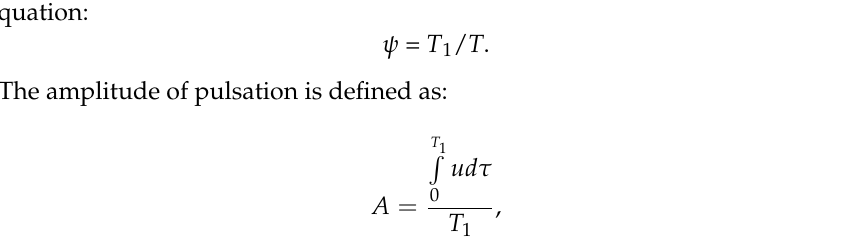
Figure 3. The pulsating velocity examples at the inlet of the computational domain: ( a ) ε = 0.743, Re = 40, ( A / D s ) St = 0.344. ( b ) ε = 0.954, Re = 25, ( A / D s ) St = 0.344. The frequency of pulsation is defined as: